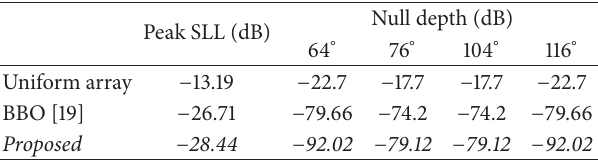
Table 16: Computational time for GWO as compared to other optimization